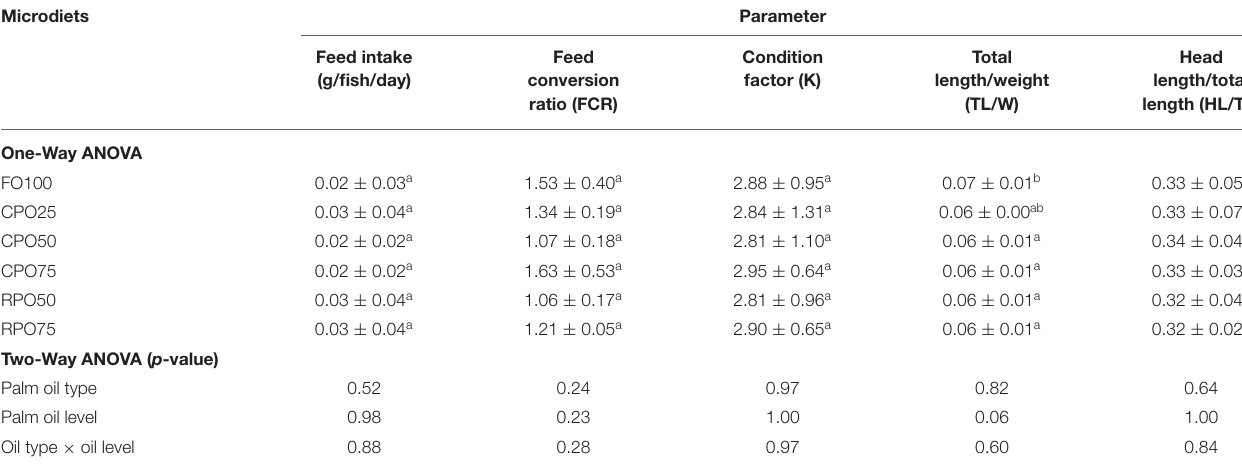
TABLE 3 | Feeding performances and body indices of Asian seabass Lates calcarifer fed different microdiets for 33 days.